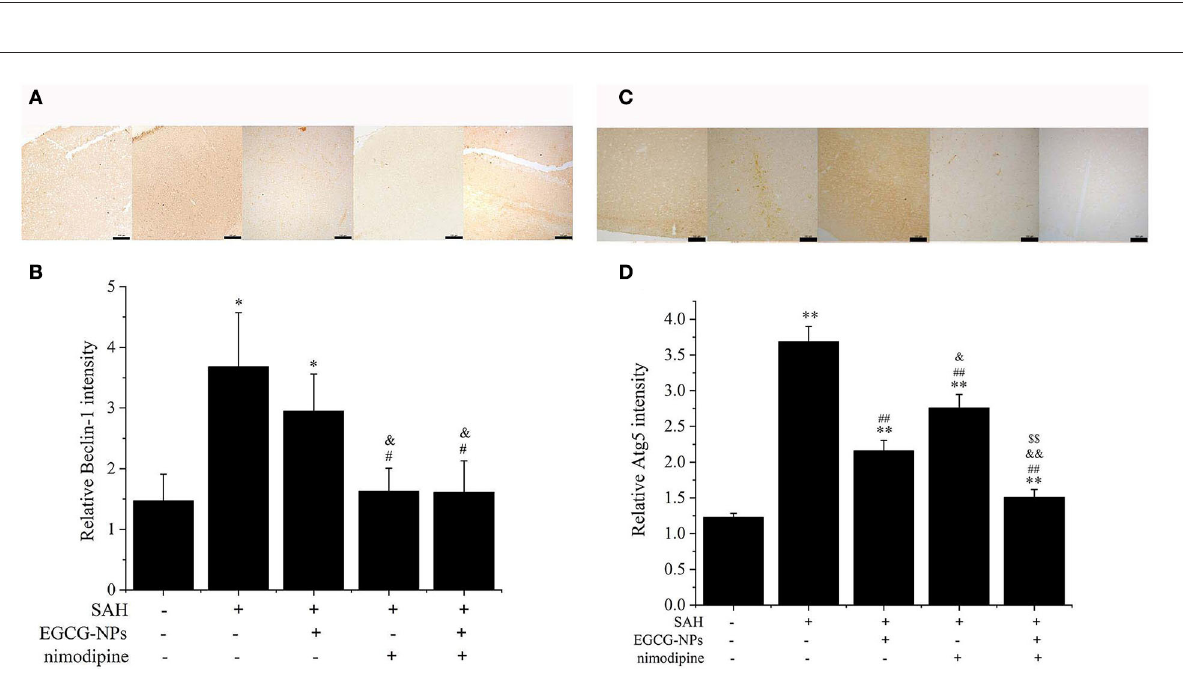
FIGURE7 Cotreatment of EGCG-NPs and nimodipine inhibited autophagy induced by OxyHb. Identification of the expression of Beclin-1, scale bar = 100 µ m (A) . Quantification of the expression of Beclin-1 (B) . Immunohistochemical microscope image of Atg5, scale bar = 100 µ m (C) . Quantification of the Atg5 level by densitometry (D) . * P < 0.05 vs. Sham, ** P < 0.01 vs. Sham; # P < 0.05 vs. SAH, ## P < 0.01 vs. SAH; & P < 0.05 vs. EGCG, && P < 0.01 vs. EGCG; $$ P < 0.01 vs.